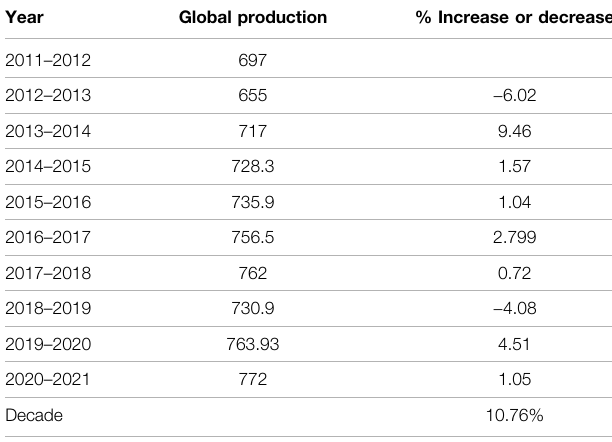
TABLE 1 | The global increase in wheat yield per year in the last decade. Year Global